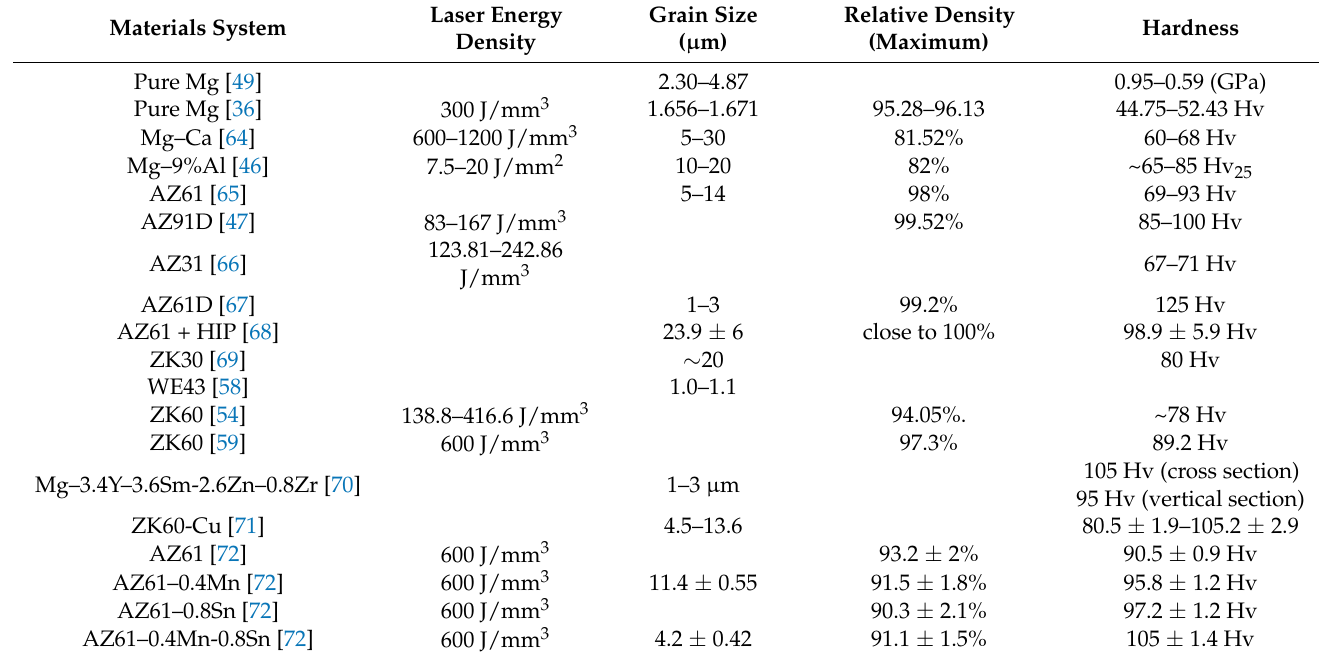
Table 1. Summary of the hardness and microstructural properties of different Mg